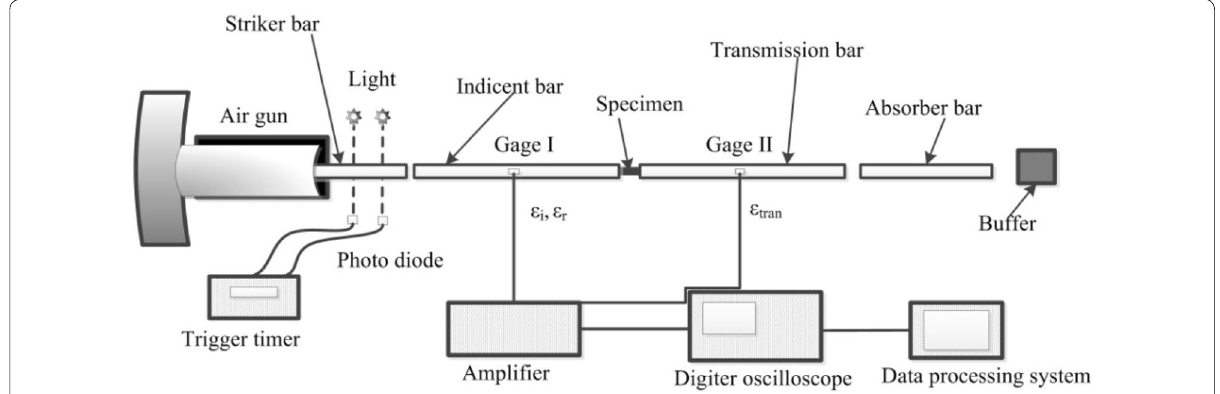
Fig. 2 Schematic of SHPB